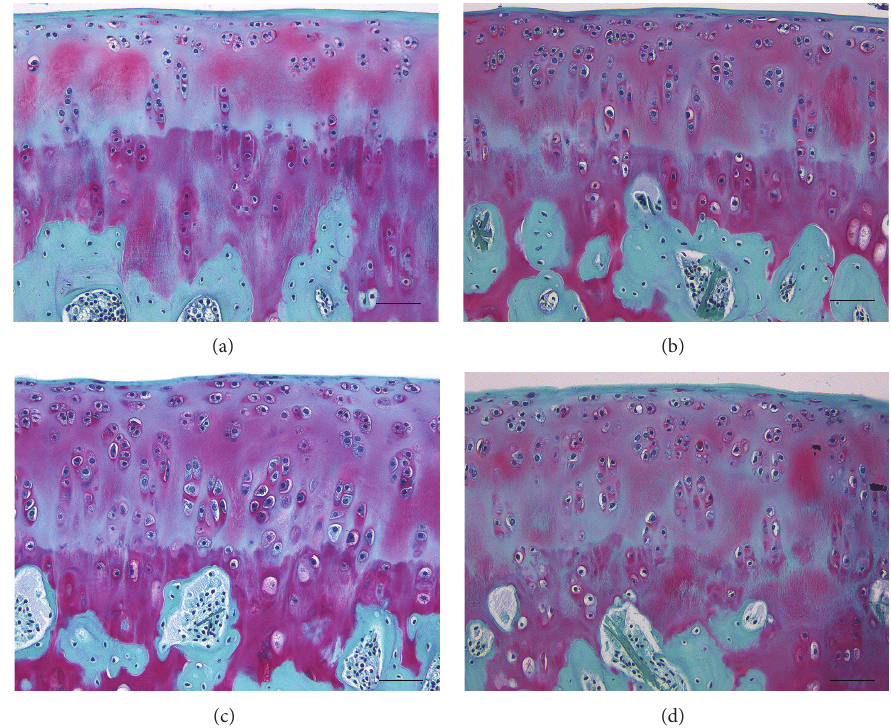
Figure 2: Representative Safranin-O stained tissue sections of OCTs after cold preservation in the presence and absence of hyaluronic acid. Safranin-O staining of OCTs was performed after 2 weeks of preservation in UW (a), UW with HA800 (b), UW with HA1900 (c), and UW with HA6000 (d). Scale bar, 100 𝜇 m.